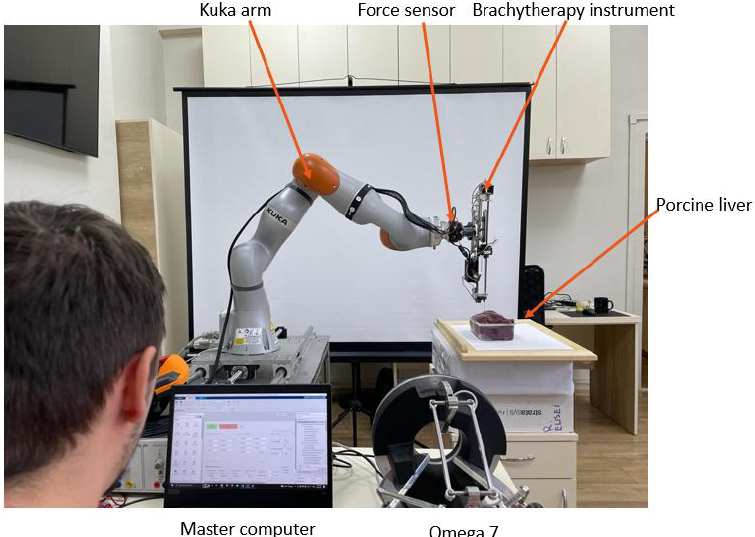
Figure 9. The experimental setup for force measurements .